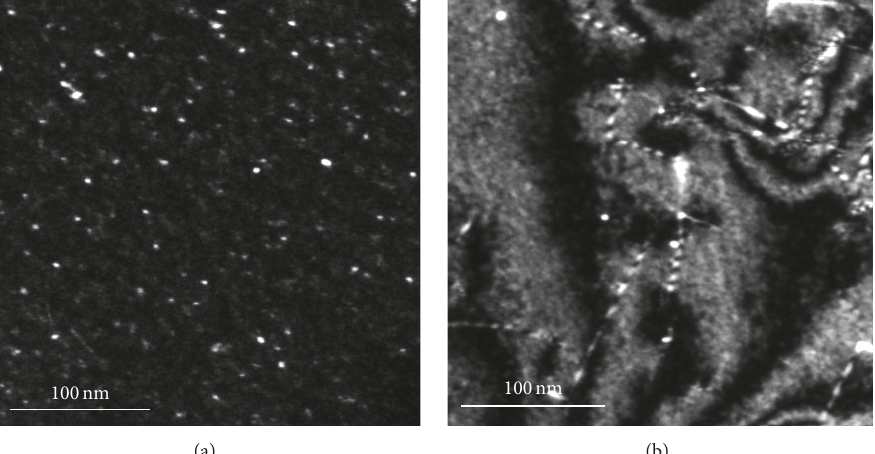
Figure 7: Radiation-induced structure elements in the 15Kh2NMFAA steel irradiated at 300 ∘ C. Dark field TEM image: precipitates (a) and dislocation loops (b).